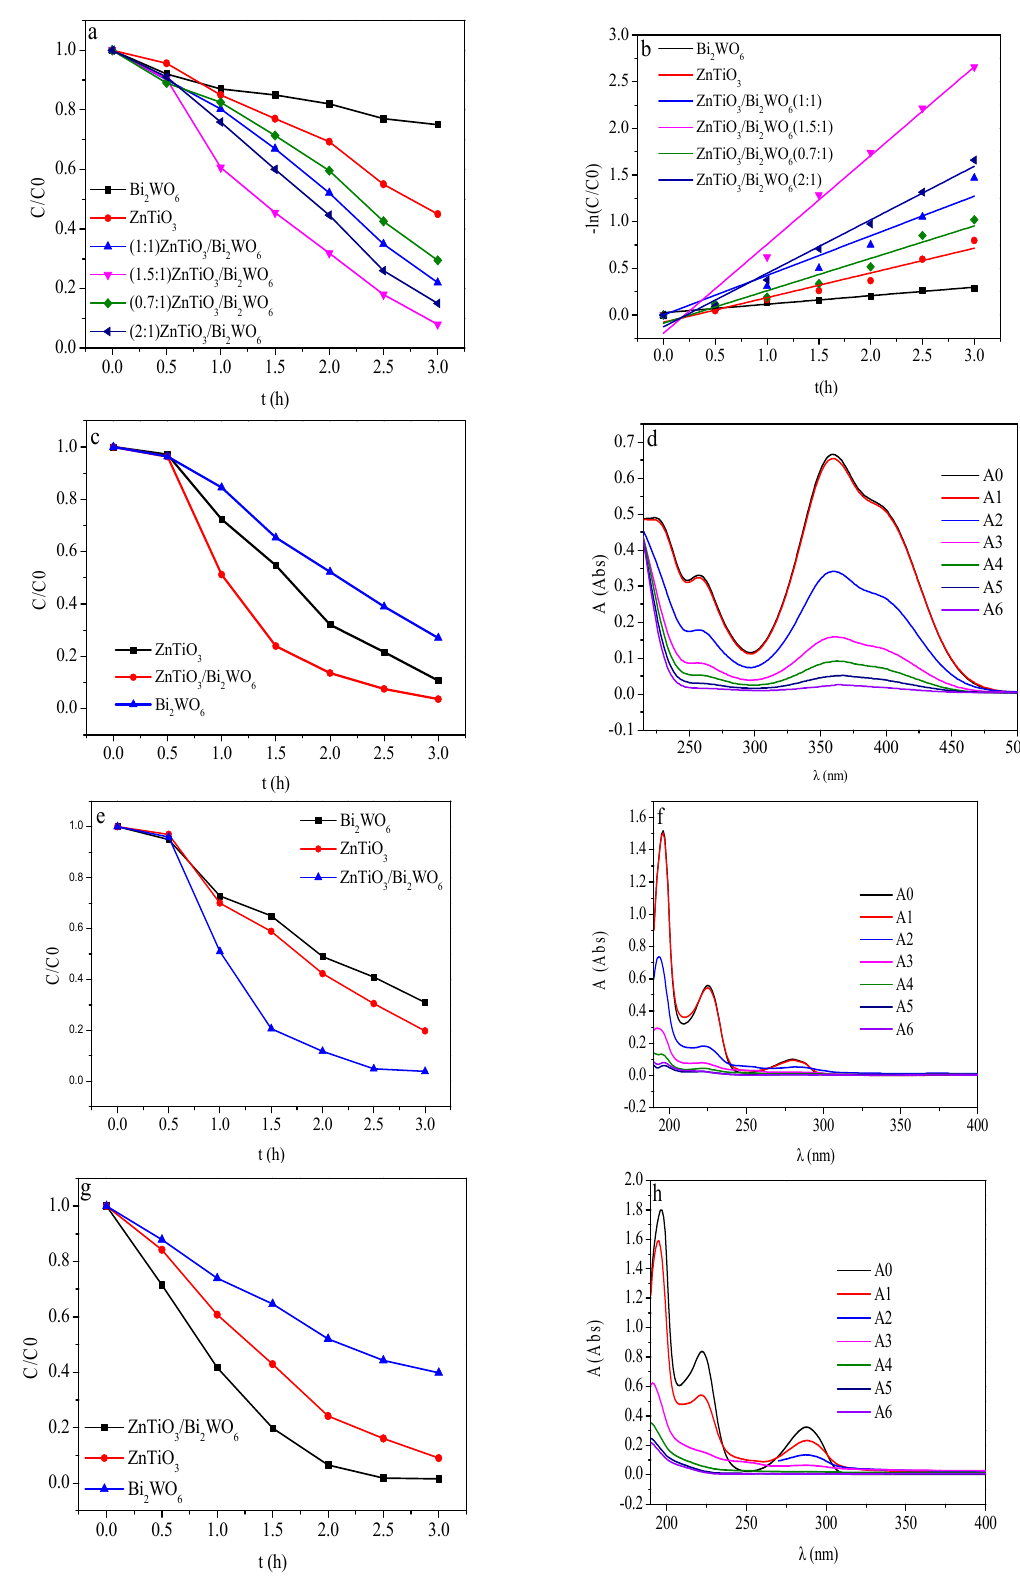
Figure 6. ( a ) Phenol degradation effect and ( b ) kinetic curve of phenol degradation of ZnTiO 3 /Bi 2 WO 6 with different molar ratios: ( c ) p-nitrophenol, ( e ) p-chlorophenol, and ( g ) p-methylphenol degradation effect by photocatalysts; and full-spectrum UV analysis of ZnTiO 3 /Bi 2 WO 6 molar ratio of 1.5:1 for ( d ) p-nitrophenol, ( f ) p-chlorophenol, and ( h ) p-methylphenol.